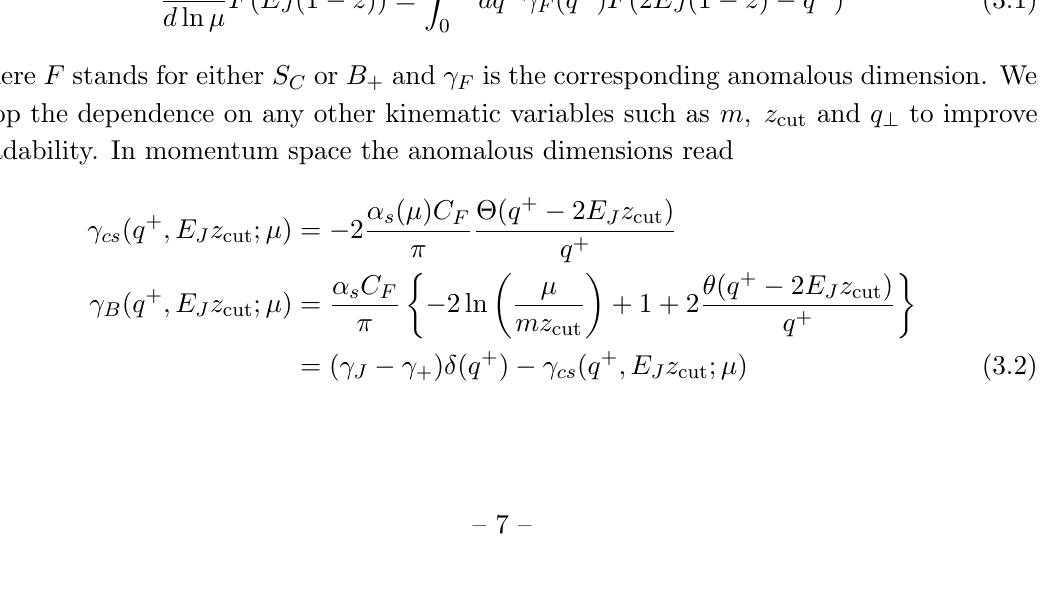
Figure 2 . Hierarchy of scales in region 2 factorization ( q soft mode that contributes to both z and q the z